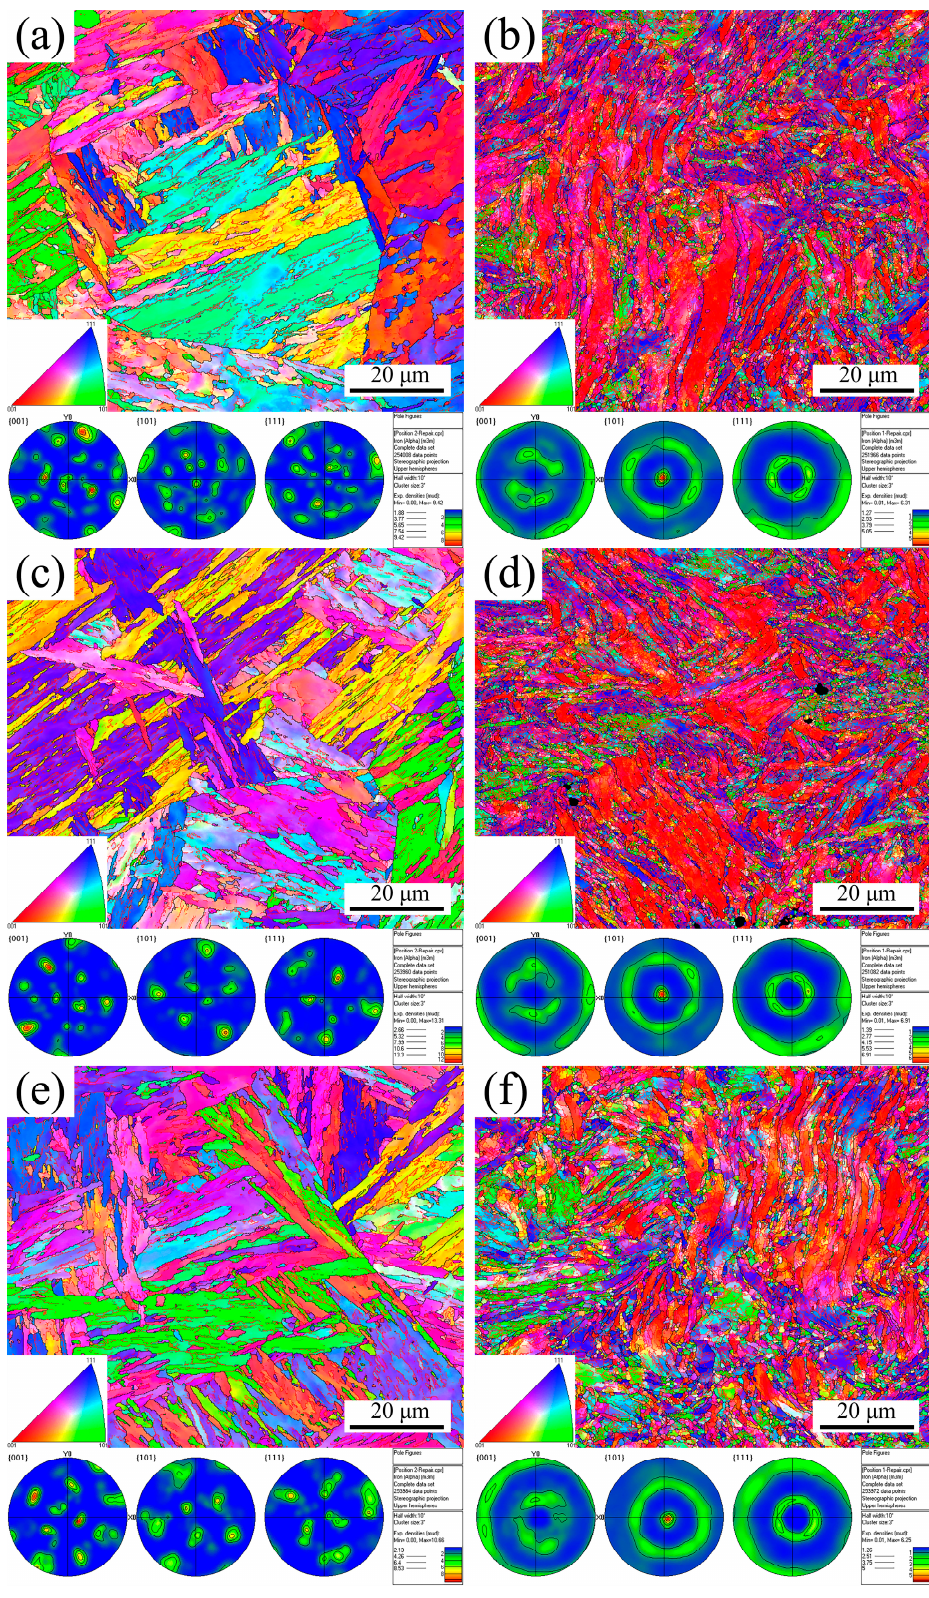
Figure 7. IPF and PF maps for the medium ( a , c , e ) and maximum ( b , d , f ) degrees of deformation at RT ( a , b ); 430 ◦ C ( c , d ); and 630 ◦ C ( e , f